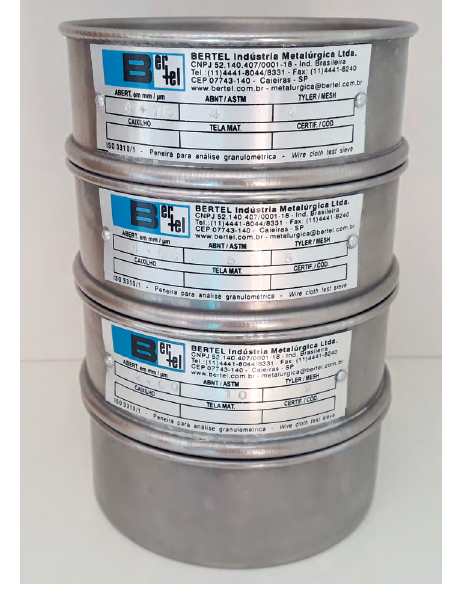
Figure 5. Sieving system vertically disposed for testing. The sieve with larger mesh spaces was placed higher, and that with smaller mesh spaces, at the